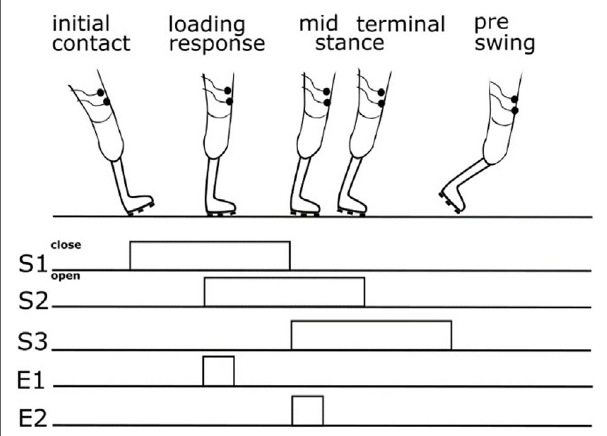
FigUre 3 | Scheme showing relation between gait cycle phase, switch closure, and feedback. S1—switch at heel, S2—switch at middle foot, S3— switch at bunion, E1—upper electrode signaling closure of the switch at the middle foot, and E2—lower electrode signaling closure of the switch at